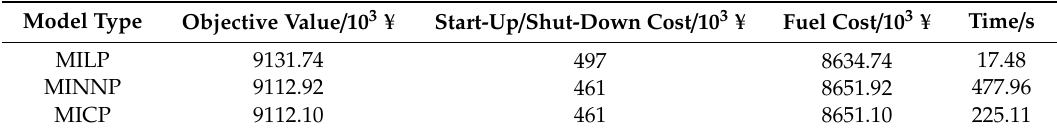
Table 8. Comparison of results computed by three SCUC models.